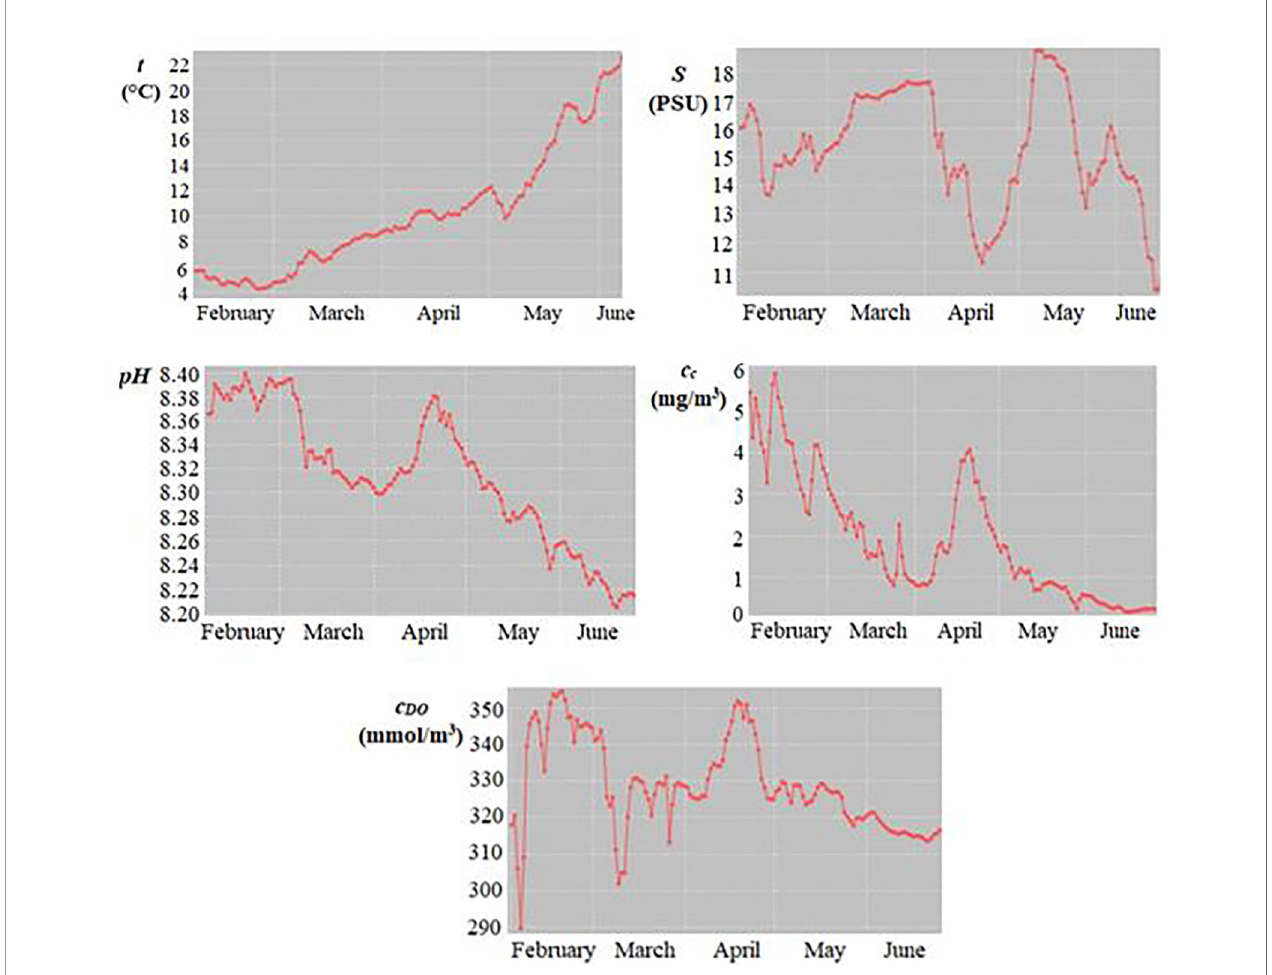
FIGURE 2 | Time variation of mean daily values of seawater temperature ( t ), salinity ( S ), pH , chlorophyll a concentration ( c c ), and dissolved oxygen concentration (